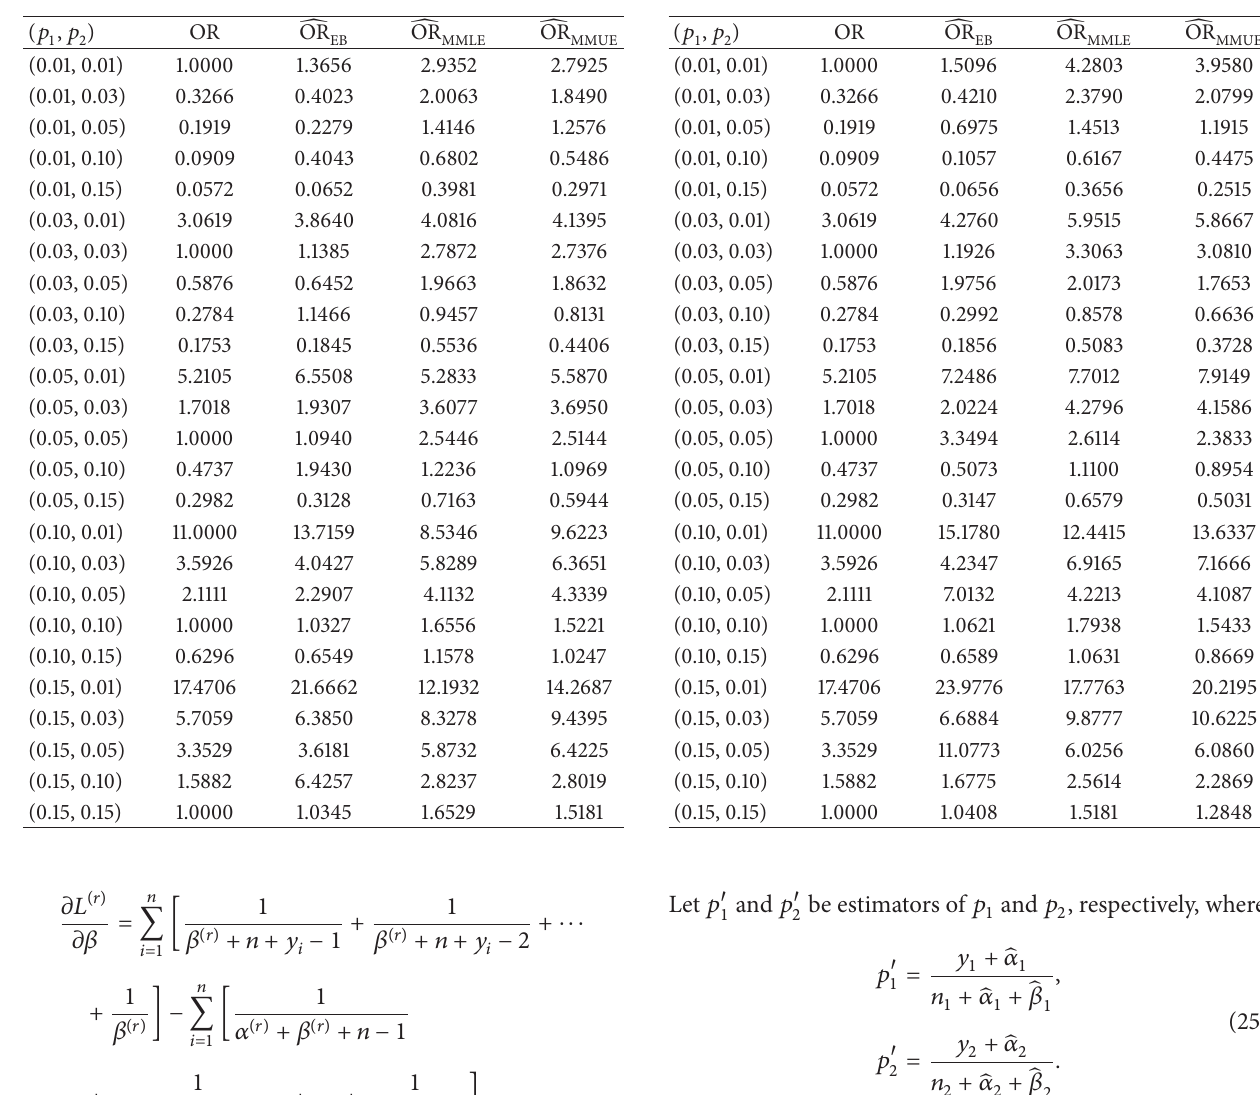
Table 2: The estimated values of odds ratio for (𝑛 1 ,𝑛 2 ) = (10, 30). Table 3: The estimated values of odds ratio for (𝑛 1 ,𝑛 2 ) = (10,